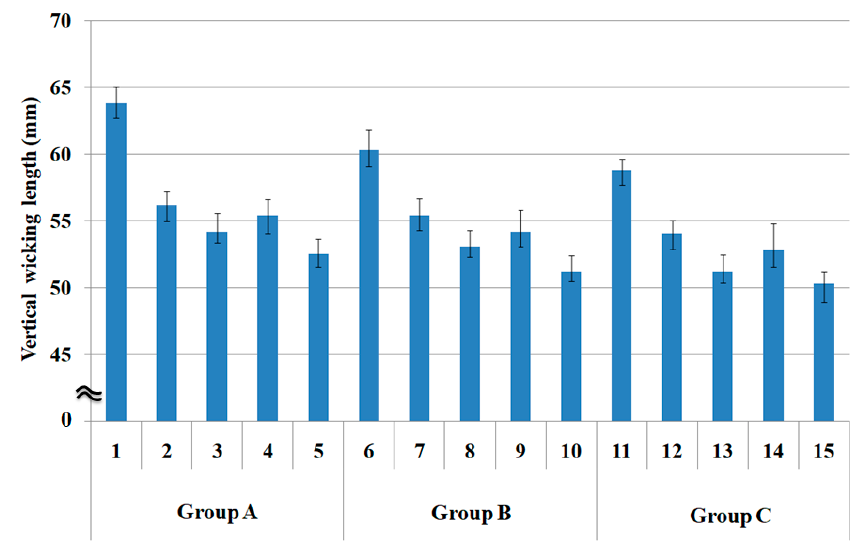
Figure 4. Vertical wicking length of the fabric specimens ( p < 0.05).